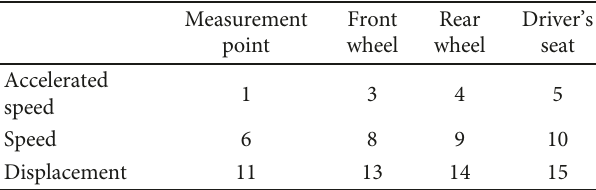
Table 4: Numbers of dynamic responses.